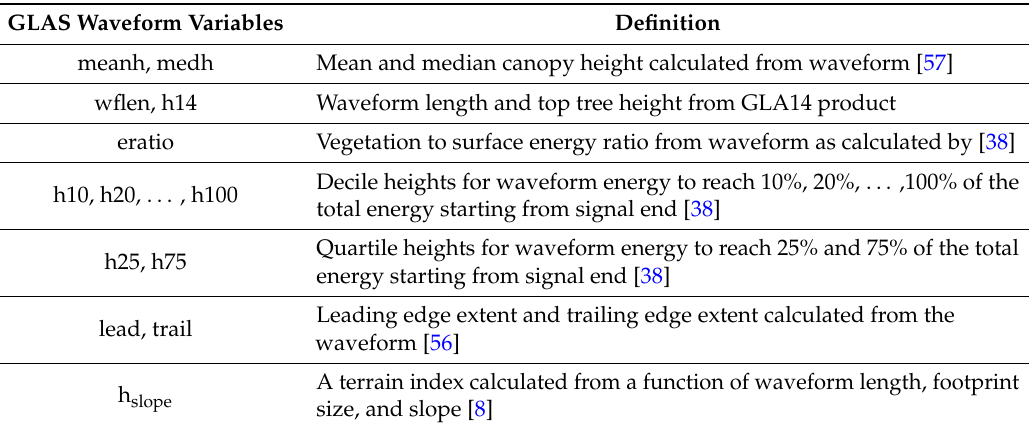
Table 2. Definition of GLAS waveform